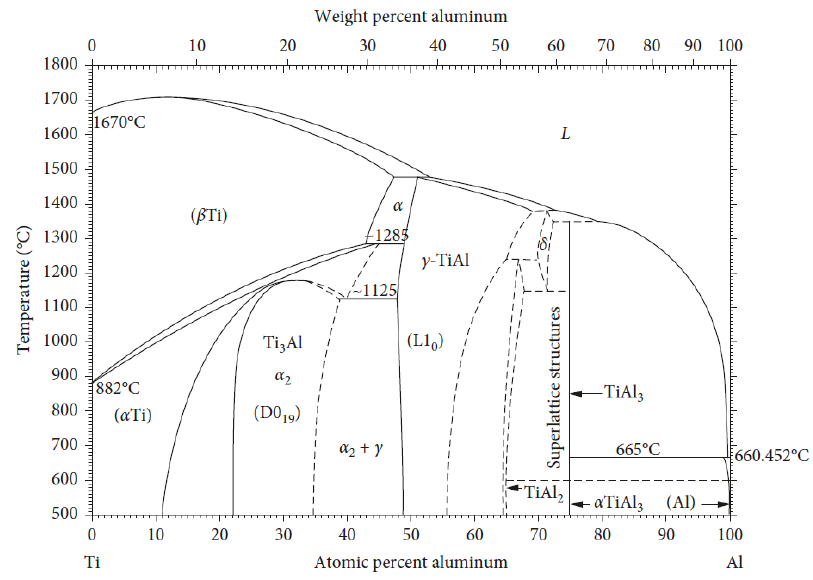
Figure 1. TiAl phase diagram [32].